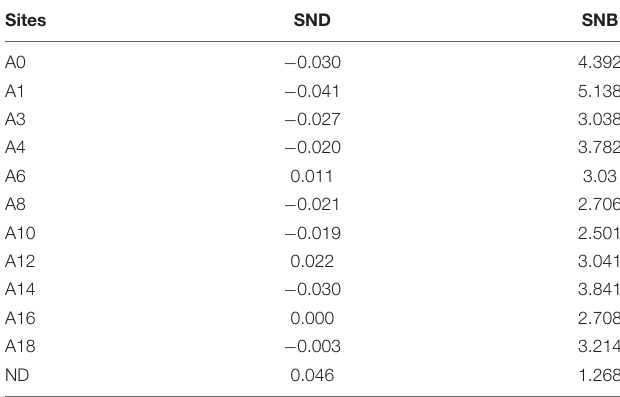
TABLE 2 | Network structure characteristics of cultivated grassland in different growing years.